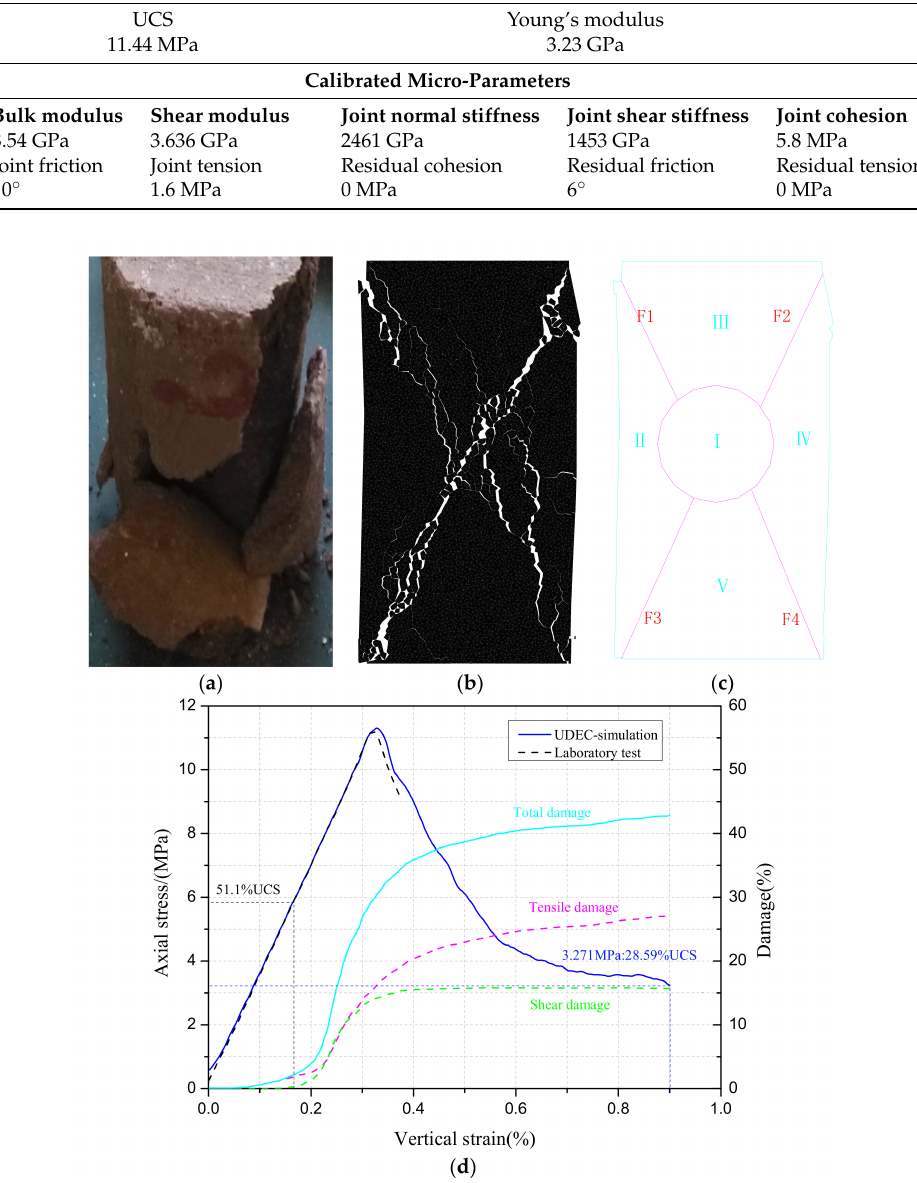
Figure 7. Experimental and numerical simulation results of uniaxial compression test. ( a ) failure pattern of the laboratory sample; ( b ) failure pattern of the numerical model; ( c ) Schematic diagram of failure pattern and ( d ) stress–strain curve of the numerical